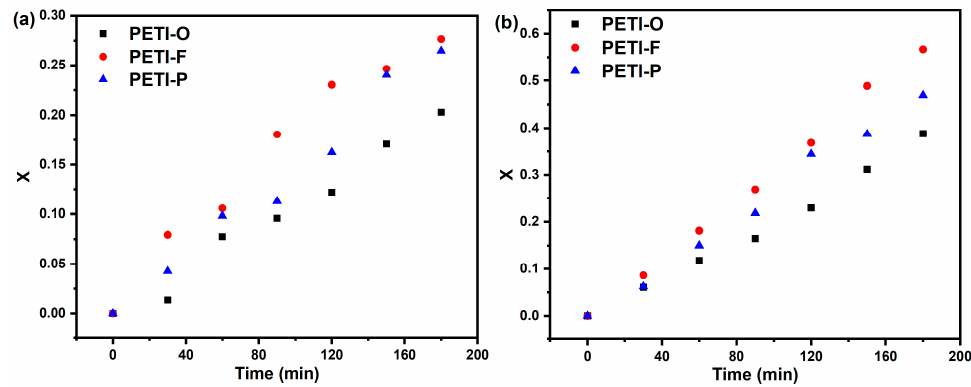
Figure 10. Extent of cure (X) vs. cure time of PETI-O, PETI-F and PETI-P at ( a ) 290 °C and ( b ) 300 °C.